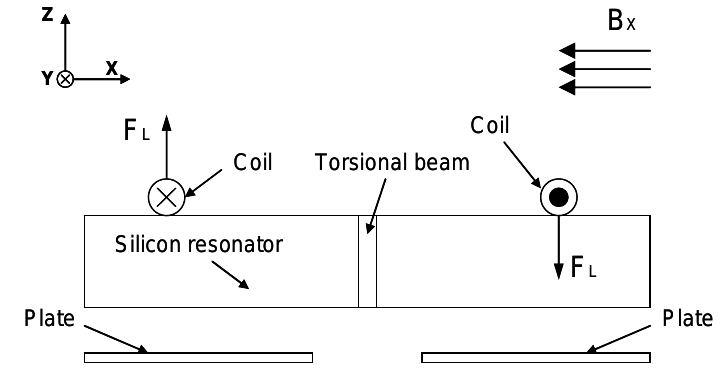
Figure 2. Operation principle of the MEMS torsional resonant